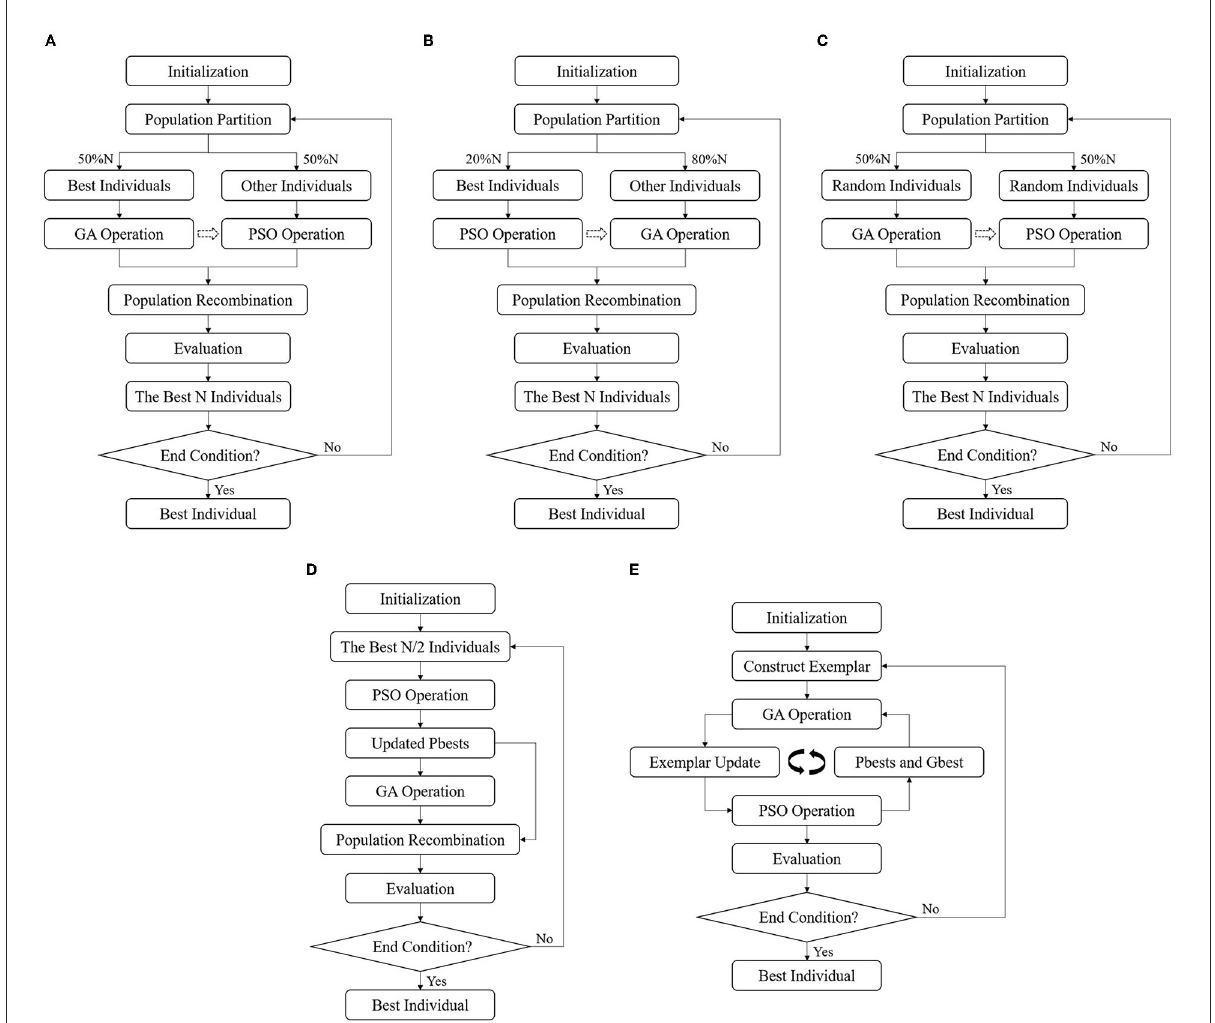
FIGURE6 The paradigms of five hybrid algorithms. (A) pGAPSO-I: the best 50% individuals were assigned to GA; (B) pGAPSO-II: the best 20% individuals were allocated to PSO; (C) pGAPSO-III: the individuals were randomly distributed to GA and PSO with equal chance; (D) sPSOGA: PSO was first executed and then GA was applied; (E) sGAPSO: GA was implemented before